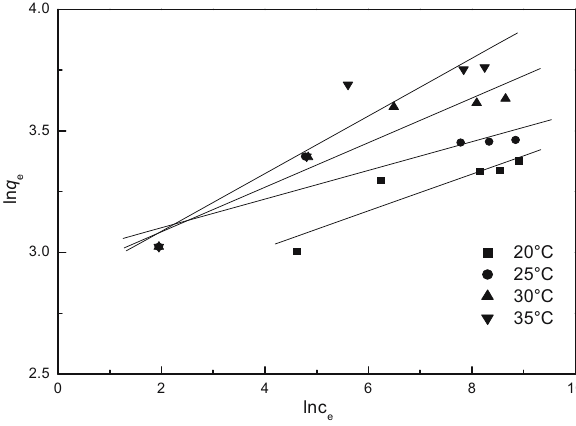
Figure 8: Freundlich isotherm plots for the adsorption of GPC on resin 001 × 7 at di ff erent